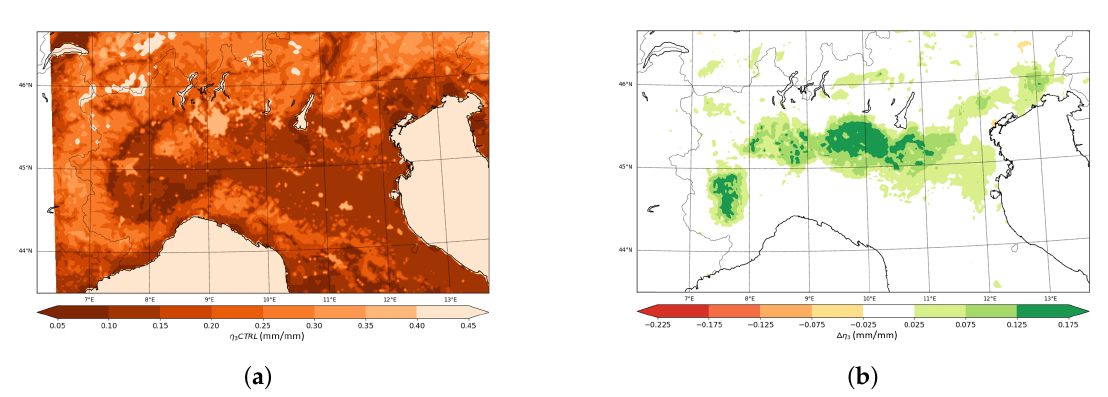
Figure 9. Third level soil moisture values ( η 3 ) for the last time-step of the simulation, Figure 9a shows the control simulation; the wilting point for most of the Po Valley soil type is 0.105. Only the DRlP run